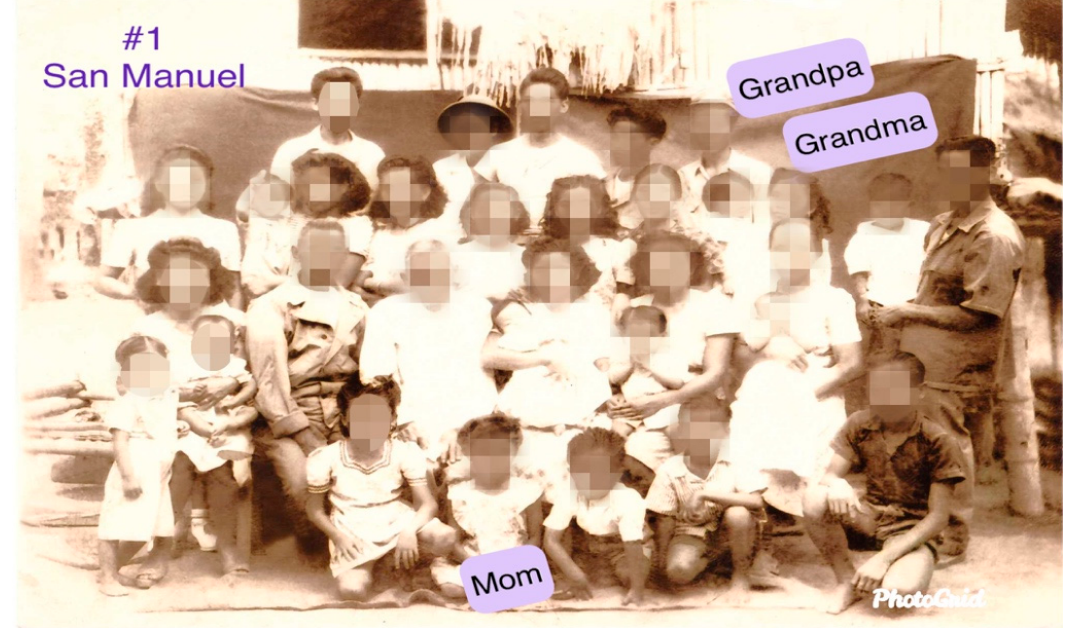
Figure 5. Crising’s maternal grandfather’s family, taken in approximately 1947, in San Manuel, Pangasinan .